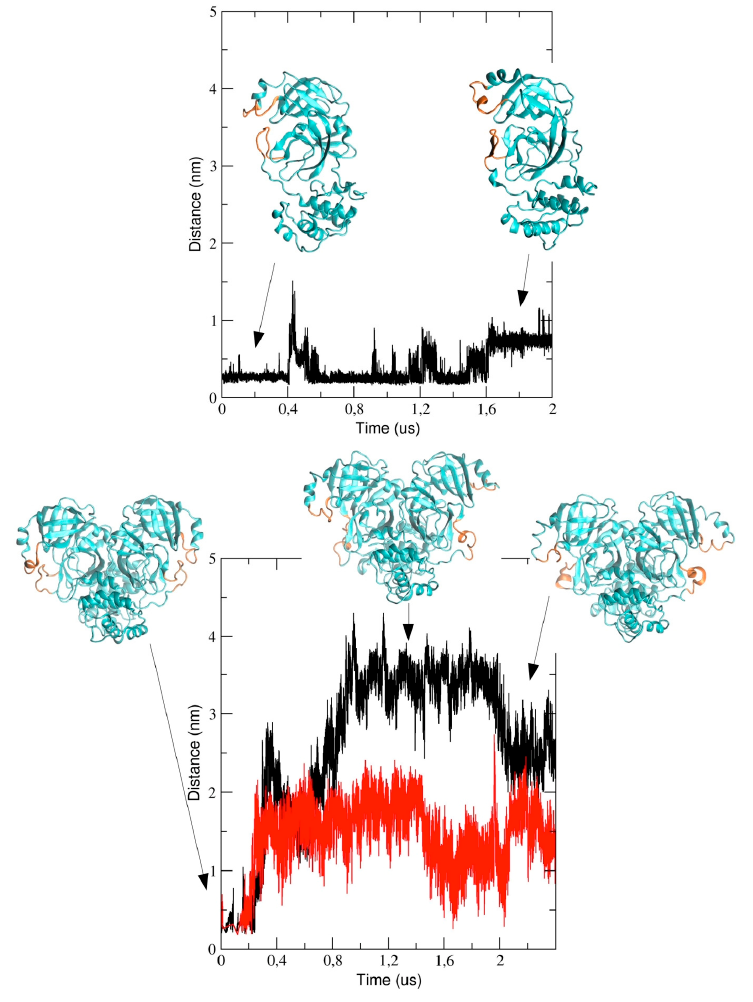
Figure 8. The distance computed between Met-49 and Arg-188 as the description of the two loop distance in the MD simulations for the monomeric 3CLpro (in the upper graph) and for the two chains in the dimeric 3CLpro (black line for chain A and red line for chain B in the lower graph) Representative structures, collected at different timesteps (indicated by black arrows) for the monomeric and dimeric 3CLpro are shown in cyan, with the two loops highlighted in orange. Similar results were obtained for runs #2 and #3 (see Figure S4, Supplementary Materials). In run #2, the loops dynamics is more dampened and the minimum distance between Met-49 and